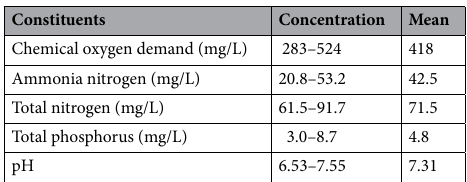
Table 1. Water characteristics of the experiment wastewater.